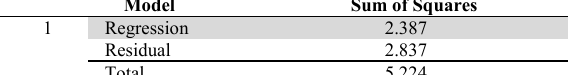
The result of ANOVA regarding the correlation of creativity (X 1 ), technology literacy (X 2 ), and risk-taking behavior (X 3 ) with innovative behavior (Y) is provided in Table 5 and Table 6. ANOVA Regression of Y against X 1 , X 2, and X 3 Model